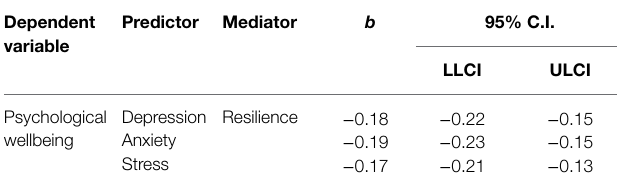
TABLE 7 | Indirect effect of depression, anxiety, and stress on psychological wellbeing, as mediated by resilience.